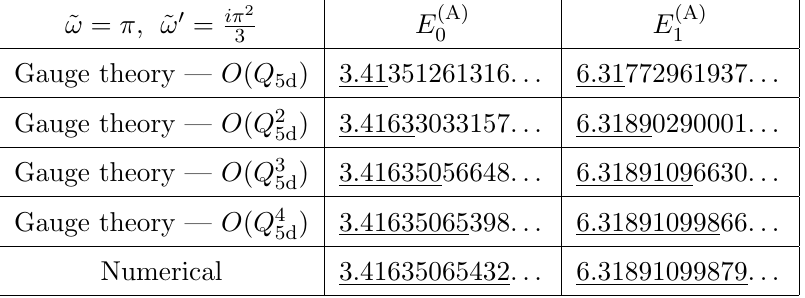
Table 11 . Gauge theory energies for the 2-eRS A model (3.12) at g y = the exact quantization conditions